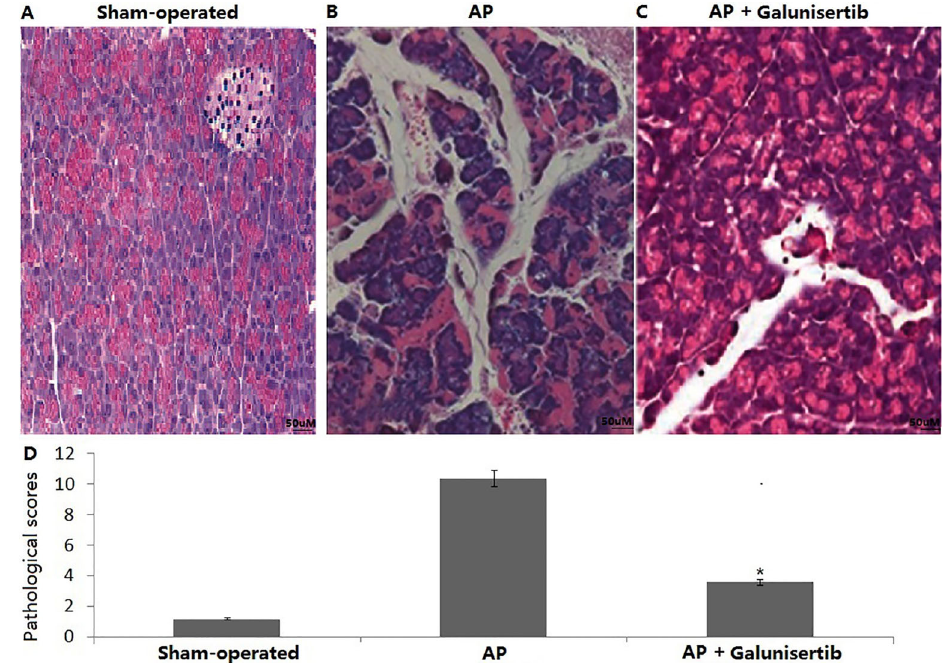
Figure 1. Pathological changes to the pancreatic tissues of the experimental groups in the acute pancreatitis (AP) model. Representative hematoxylin and eosin-stained sections were examined by light microscopy (original magni fi cation, (cid:4) 200). A , No obvious histological alterations were observed in the pancreatic tissues from the sham-operated rats; B , histological signs of pancreatic injury can be observed in the AP group; C , pretreatment with galunisertib showed signi fi cantly reduced injury in extent and severity; D , comparison of the total pathological scores of the pancreas in the three groups. Results are reported as means ± SD (n=10 rats per group) vs the AP group, *P o 0.05 (Student ’ s t